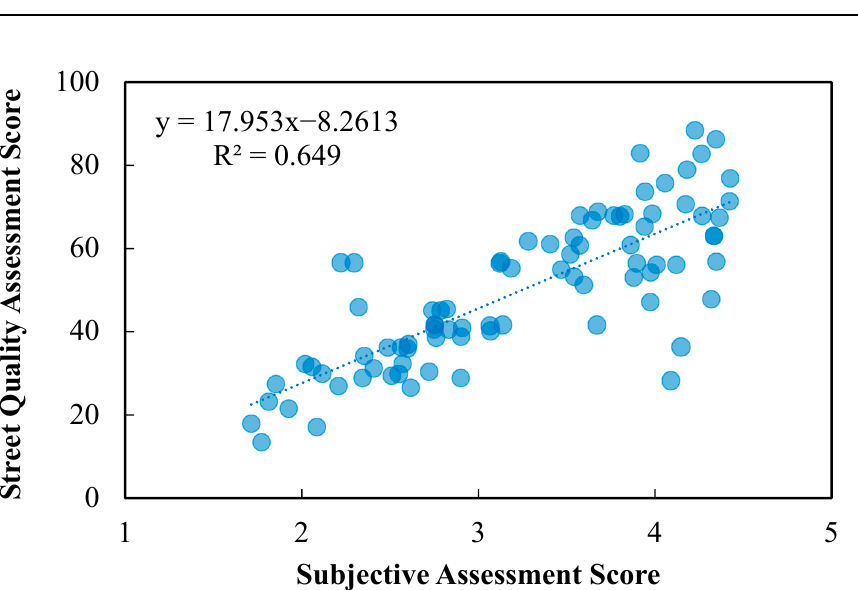
y = 17.953x−8.2613 R² = 0.649